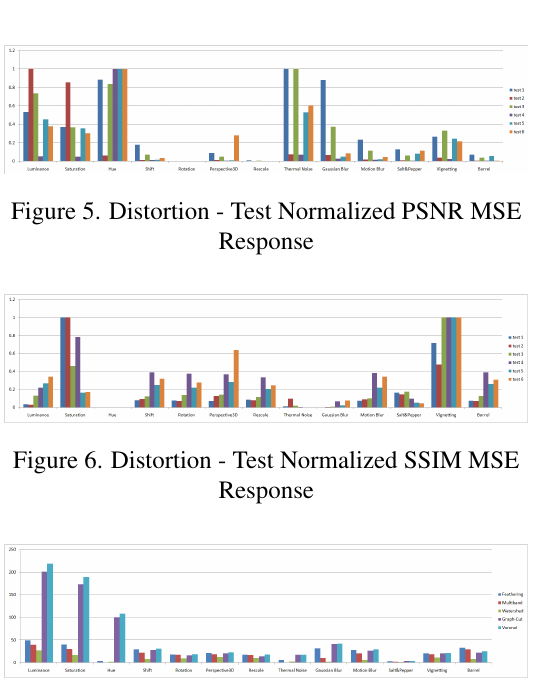
Figure 7. Distortion - Mosaicing PSNR MSE Response